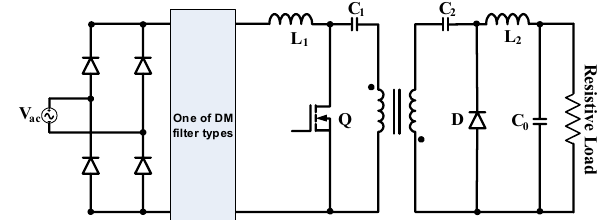
Figure 1. PFC single phase isolated Ćuk AC-DC converter.